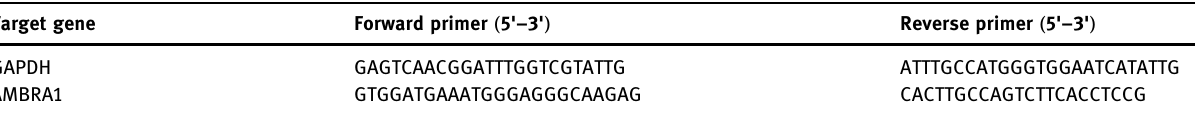
Table 3: Sequences of the primers used in RT - qPCR Target